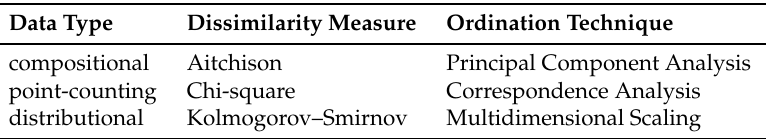
Table 1. A summary of the three types of provenance data introduced in this paper along with a suitable dissimilarity measure and its corresponding ordination